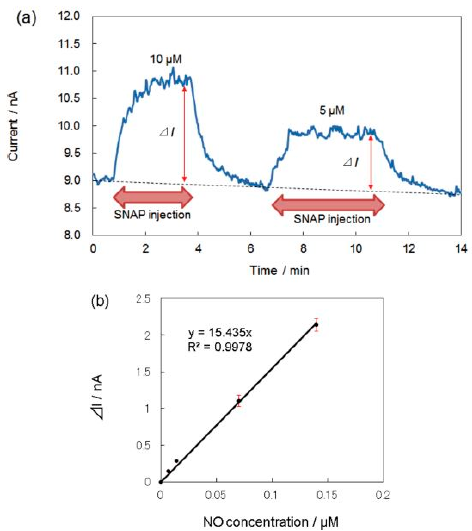
Figure 5. ( a ) Amperometric detection of NO at the FeT3ThP-modified electrode. The electrode potential was +0.8 vs. Ag/AgCl. ( b ) Calibration curve for NO detection at the FePor-modified electrode [58].